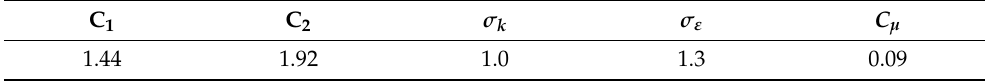
Table 4. Constants is used in the k– ε model.